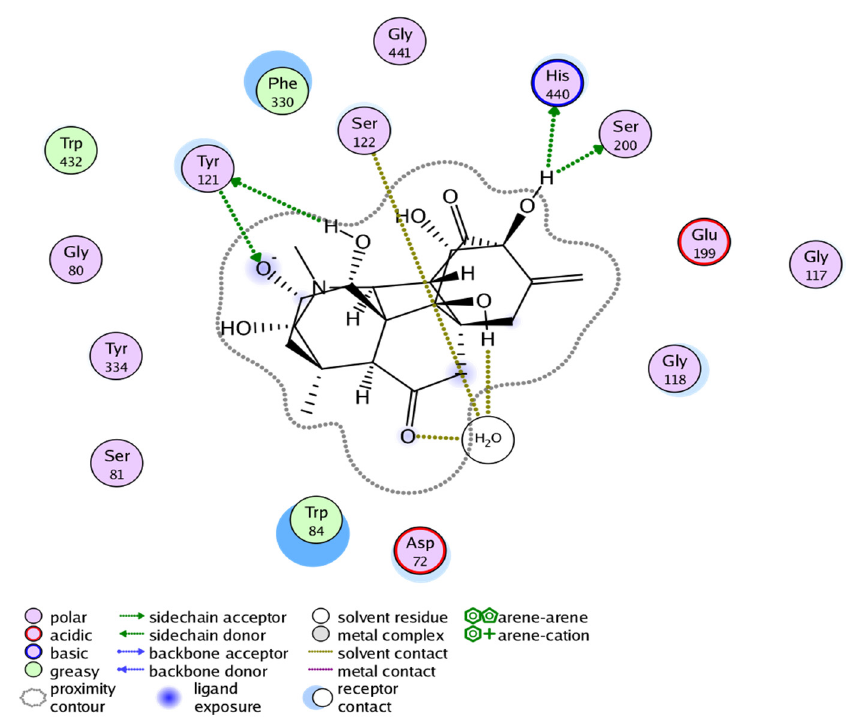
Figure 8. Docking pose of Compound 2 within cholinesterase target (Docking score of = − 15.591).